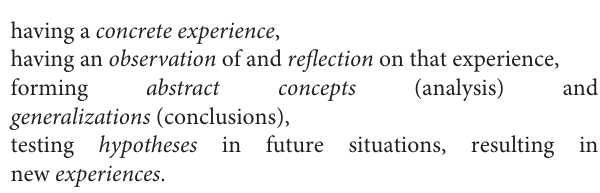
FIGURE 2 | Illustration of the different phases a learner goes